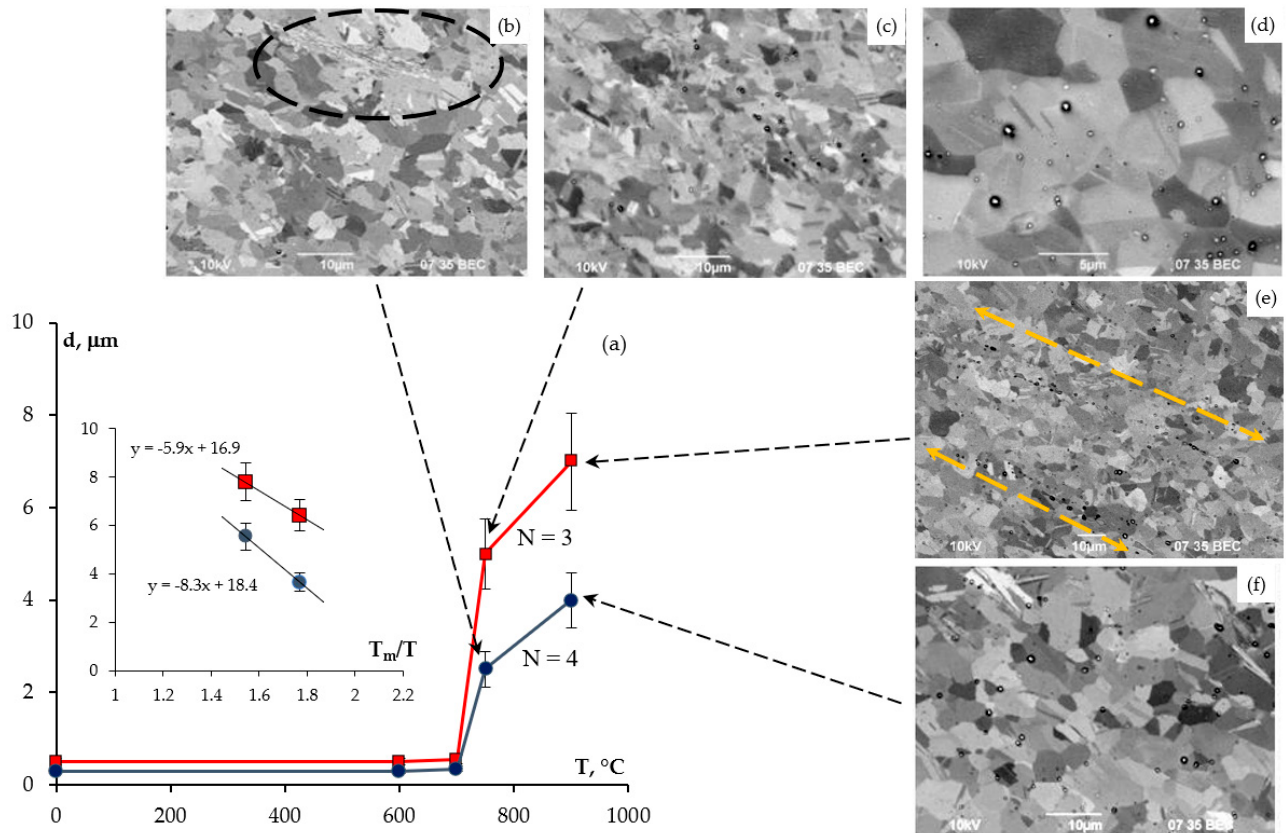
Figure 6. Dependences of mean grain sizes on 1-hour annealing temperature for UFG steel speci- mens subjected to ECAP at Т ECAP = 450 ° С ( a ) and SEM images of microstructure after annealing at different temperatures: ( b ) 750 °C (ECAP, N = 4 at 450 °C); ( c , d ) 750 °C (ECAP, N = 3 at 450 °C); ( e ) 900 °C (ECAP, N = 3 at 450 °C); ( f ) 900 °C (ECAP, N = 4 at 450 °C).